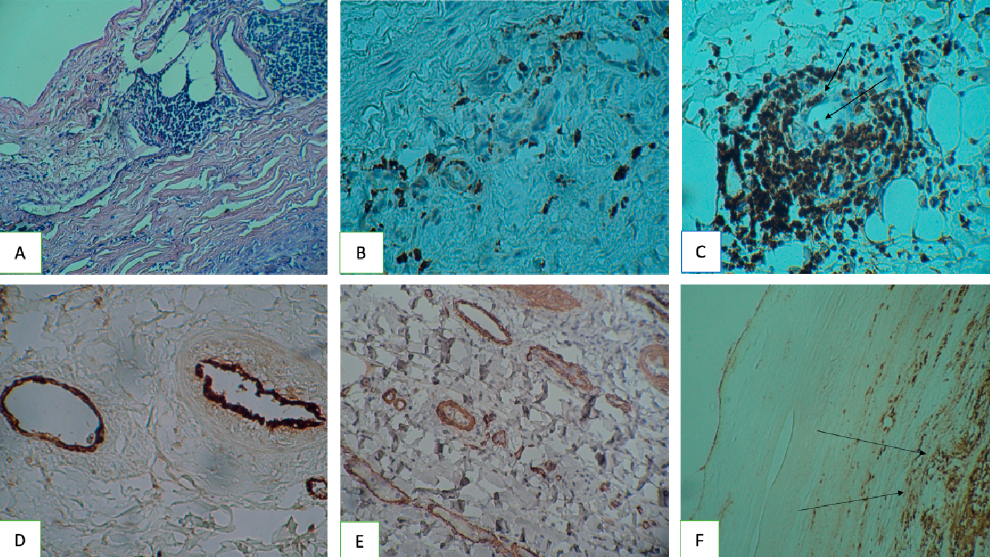
Figure 1. Inflammatory infiltrates and vasa vasorum in the aortic aneurysm wall, ICH staining. ICH—Immunohistochemistry ( A ) lymphoid infiltration of adventitial vasa vasorum. Hematoxylin and Eosin stain, magnification ×100; ( B ) CD4+ T cells in the area of the newly formed vasa vasorum, magnification ×200; ( C ) adherent CD8+ T-cells on the vasa vasorum endothelium (indicated by a long arrow), magnification ×200; ( D ) von Willebrand factor antibodies for detection vasa vasorum endothelium, magnification ×100; ( E ) vasa vasorum smooth muscle α -actin, magnification ×200; ( F ) Lp(a) accumulations in a fibrous plaque (indicated by a long arrow), magnification × 200. Table 1. Aortic aneurysm biopsy. Comparison of inflammatory infiltrates from T cells with Lp(a) deposits. Number of T Cells Lp(a) (-) Lp(a) ( ++